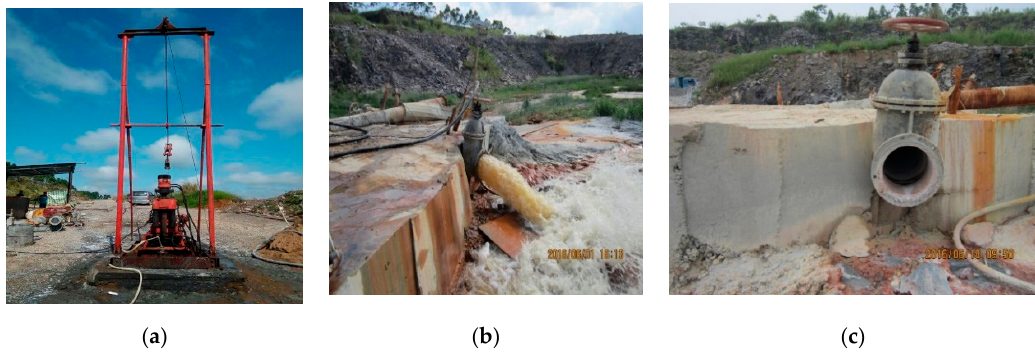
Figure 12. D3 grouting ( a ) and the collection points before ( b )/after ( c ) plug off.